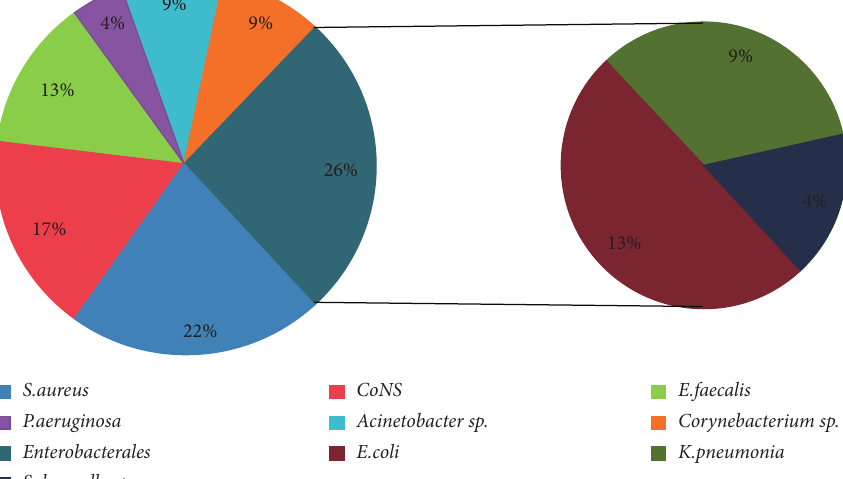
Figure 1: The causative agents of sepsis in adult patients.